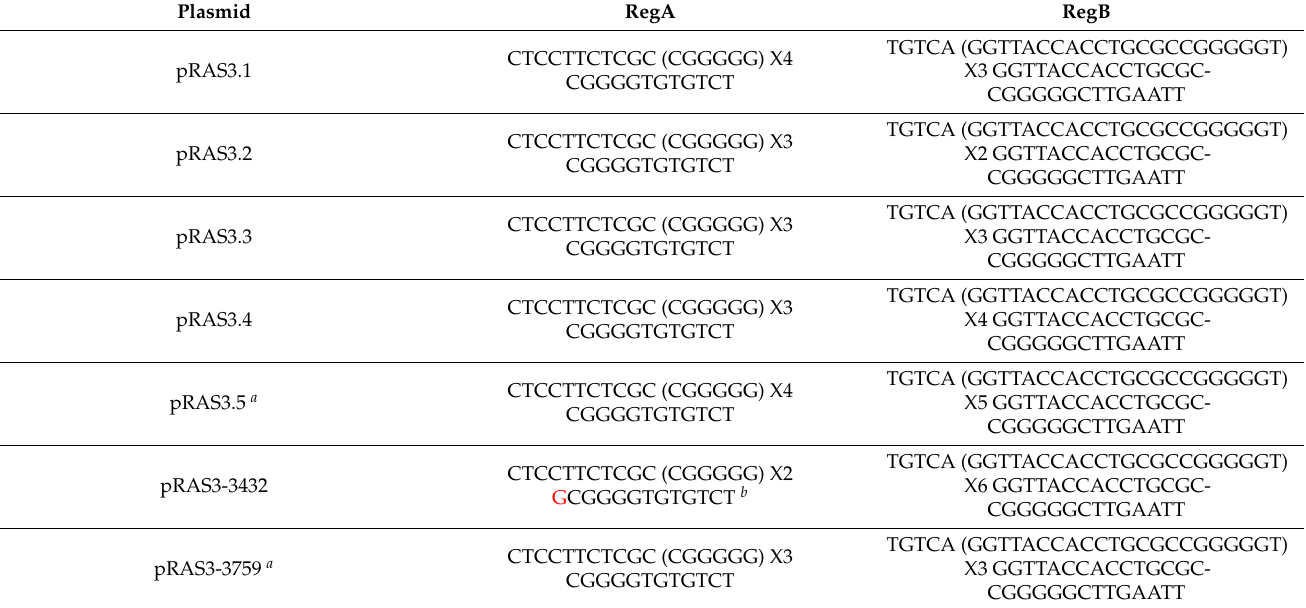
Table 2. Repeat sequences at regions A (RegA) and B (RegB) in the seven pRAS3 plasmids found in A. salmonicida subsp. salmonicida